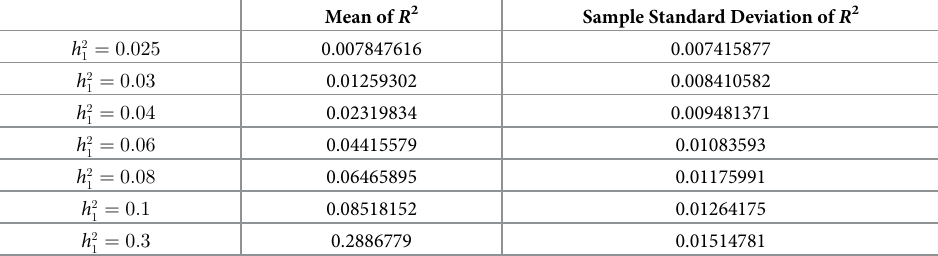
Table 1. Comparisons of R 2 of imputed gene expression under different levels of expression heritability and num- ber of genetic variants. Mean of R